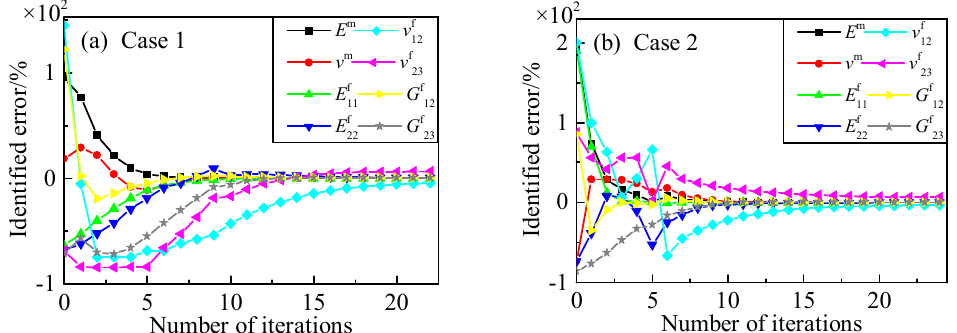
Figure 6. Identified process for constituent parameters with six points (the direct derivation method). ( a ) initial values: E m = 8 GPa, ν m = 0.45, E f 11 = 100 GPa, E f 22 = 6 GPa, ν f 12 = 0.49, ν f 23 = 0.1, G f 12 = 60 GPa, G f 23 = 2 GPa; ( b ) initial values: E m = 12 GPa, ν m = 0.1, E f 11 = 800 GPa, E f 22 = 5 GPa, ν f 12 = 0.6, ν f 23 = 0.6, G f 12 = 50 GPa, G f 23 = 1